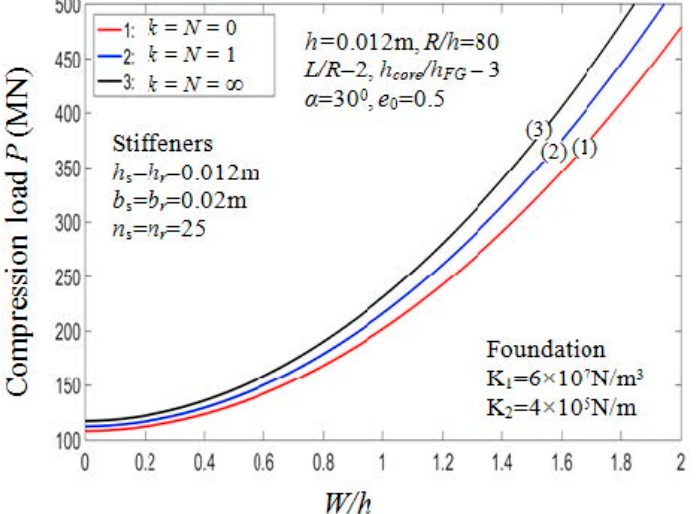
Figure 11. Effects of volume fraction indexes on postbuckling load—deflection curves (Case 1).